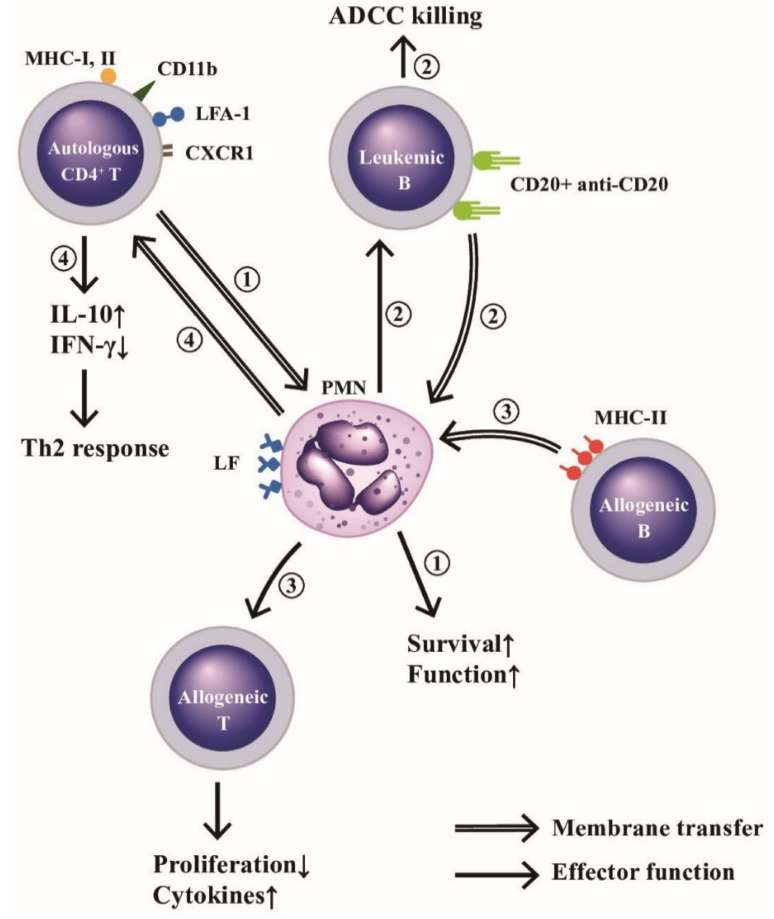
Figure 5. Membrane transfer among neutrophils and autologous CD4 + T, allogeneic B or leukemic B cells for mediating respective effector function. ( 1 ) PMNs “trogocytose (bite up)” immunological synapse-associated molecules (HLA-I and II, CD11b, LFA-1, and CXCR1) to enhance their biological functions and survival rate. ( 2 ) PMNs trogocytose CD20-anti-CD20 complex from leukemia B cells and then kills these tumor cells by ADCC mechanism. ( 3 ) PMNs trogocytose MHC-II antigens from allogeneic B lymphocytes and then present MHC-II to allogeneic T cells to enhance proliferation and cytokine production of the allogeneic T cells, and ( 4 ) Autologous CD4 + T cells trogocytose lactoferrins (LFs) expressed on PMNs to enhance IL-10 and IFN- γ production for skewing cells to Th2 immune responses. ADCC: antibody-dependent cell-mediated cytotoxicity. MHC: major histocompatibility complex; LFA: lymphocyte function-associated antigen; CD: cluster of differentiation; CXCR: cysteine- amino acid X-cysteine chemokine receptor; IFN: interferon; IL: interleukin; HLA: human leukocyte